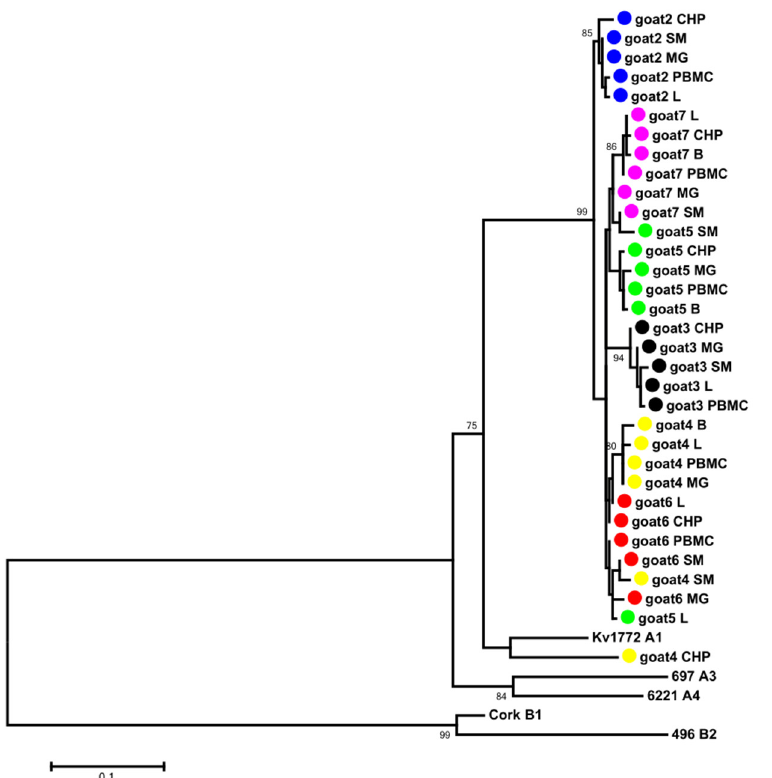
Figure 6. Maximum-likelihood phylogenetic tree based on the alignment of the LTR fragment. Sequences from this study are labeled by black circles. Numbers at the branches indicate the percentage of bootstrap values obtained from 1000 replicates. Bootstrap values >70% are shown. PBMC—Peripheral blood mononuclear cells, L—Lung, SM—Synovial membrane, B—Brain, CHP—Choroid plexus, MG—Mammary gland, goat 2—Blue, goat 3—Black, goat 4—Yellow, goat 5—Green, goat 6—Red, goat 7—Pink.